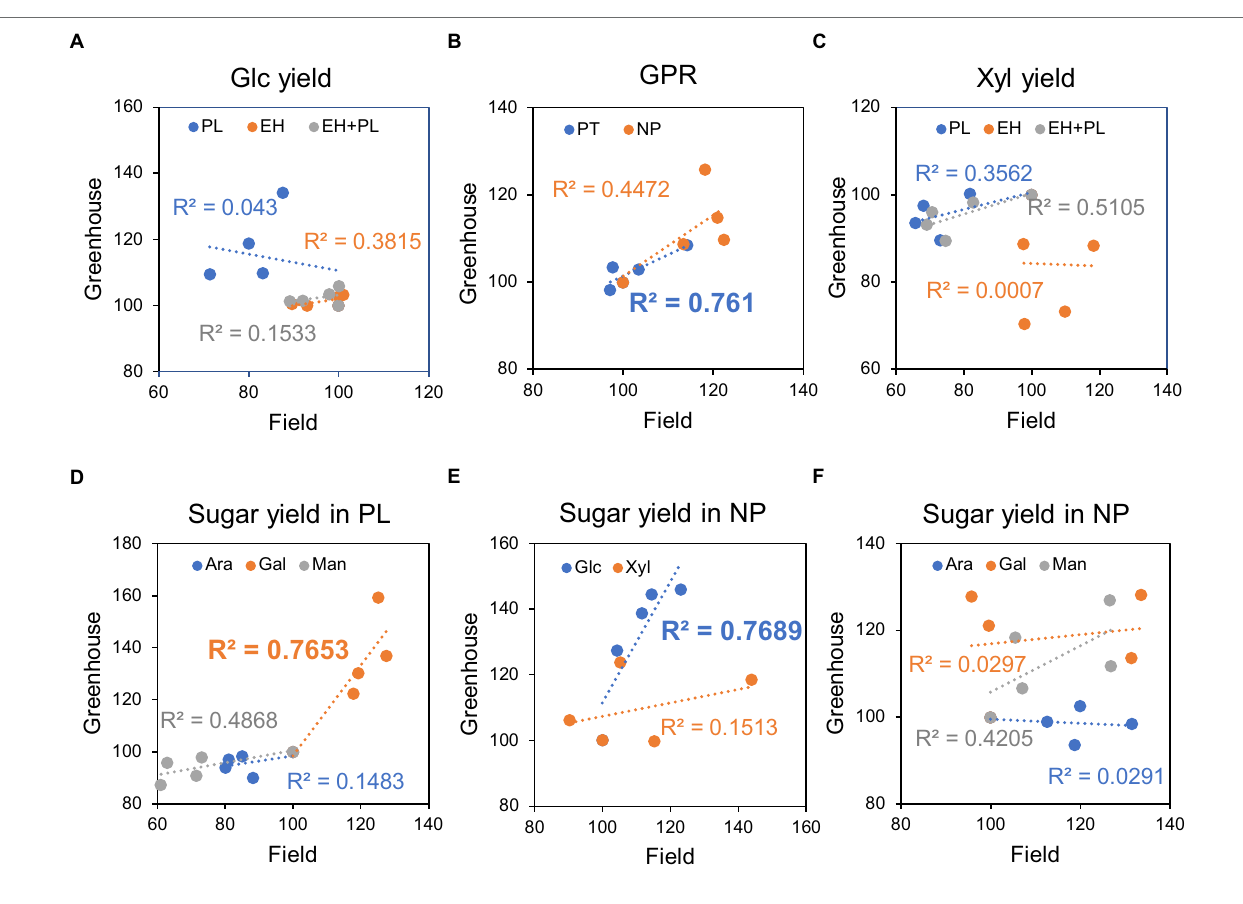
FIGURE 7 | Relationships between saccharification yields and GPR from material of plants grown in the field and greenhouse. Data for developing wood of four transgenic ( WP:AnAXE1 ) and wild-type (WT) lines in percentages of WT values. Coefficients of linear correlation ( R 2 values) are shown. (A) Glucose yields in saccharification with acid pretreatment. (B) Glucose production rates. (C) Xylose yields in saccharification with pretreatment. (D) Minor sugar yields in saccharification with pretreatment. (E) Glucose and xylose yields in saccharification without pretreatment. (F) Minor sugar yields in saccharification without pretreatment. NP, not pretreated; PT, with acid pretreatment; EH, yields in enzymatic hydrolysis; PL, yields in pretreatment liquid; and EH + PL, total yields. R 2 values significant at p < 10% (according to ANOVA F -tests) are emboldened.